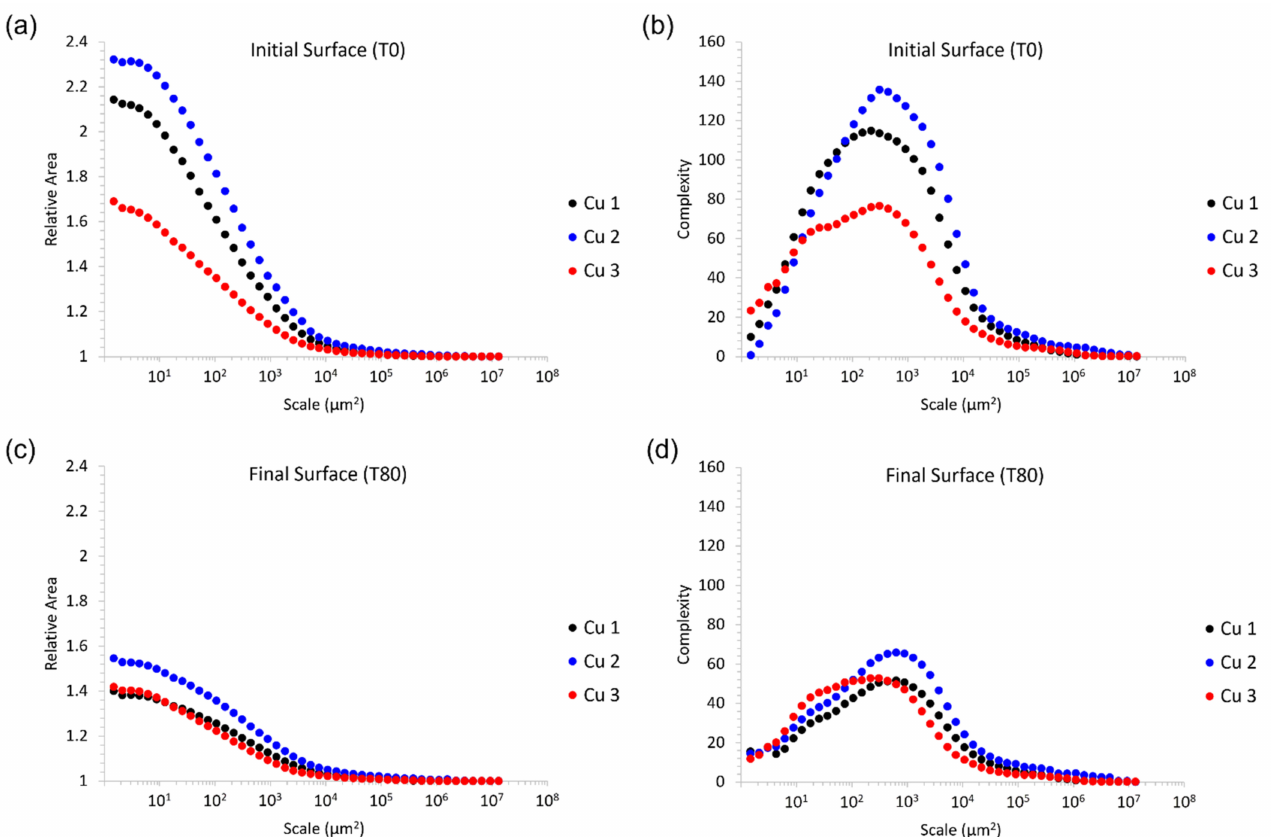
Figure 5. Initial vs. final surface finish. ( a , c ) Relative area compared for Cu 1–3, ( b , d ). Complexity compared for Cu